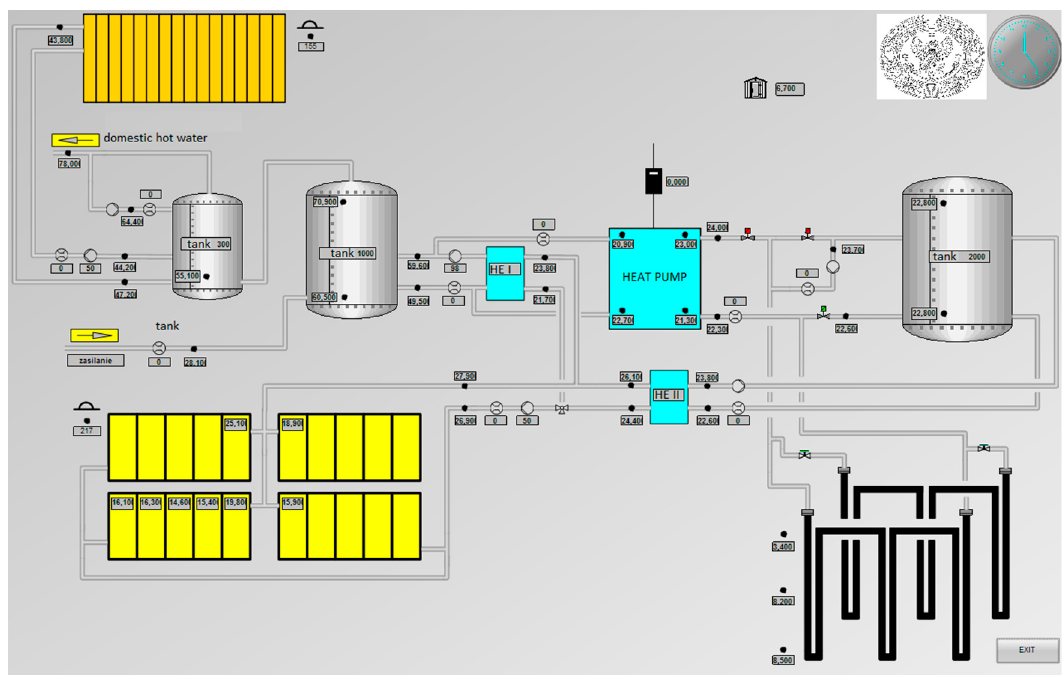
Figure 6. Visualization of work of test stand II in the SCADA system.